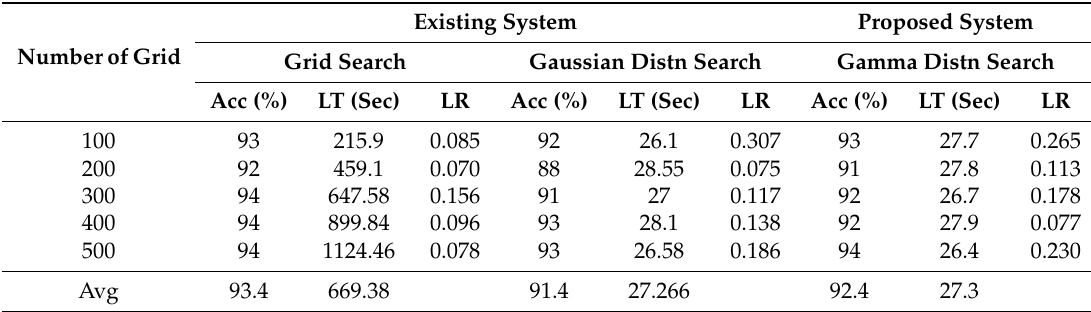
Table 8. Comparison of grid search, Gaussian distribution search, and Gamma distribution search applying 20 counts of optimization and 50 epochs. LT, learning time; LR, learning